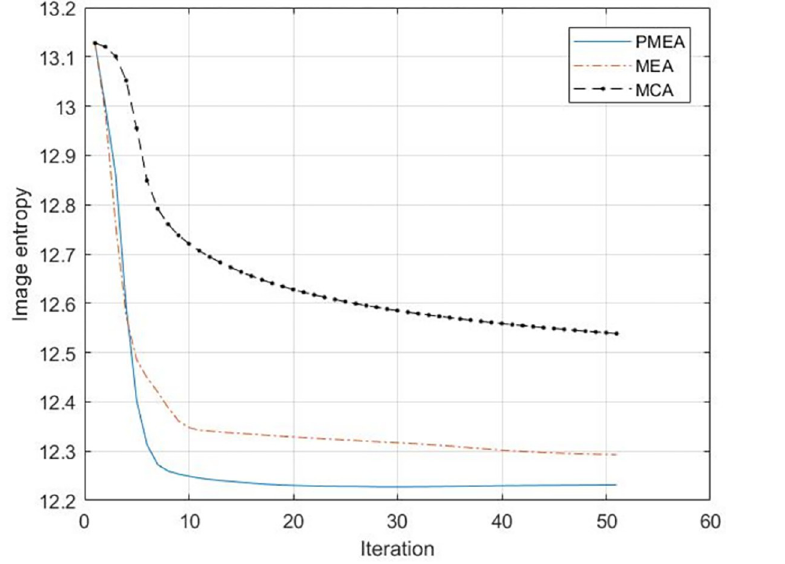
Fig 13. Results of entropy curve of real data.